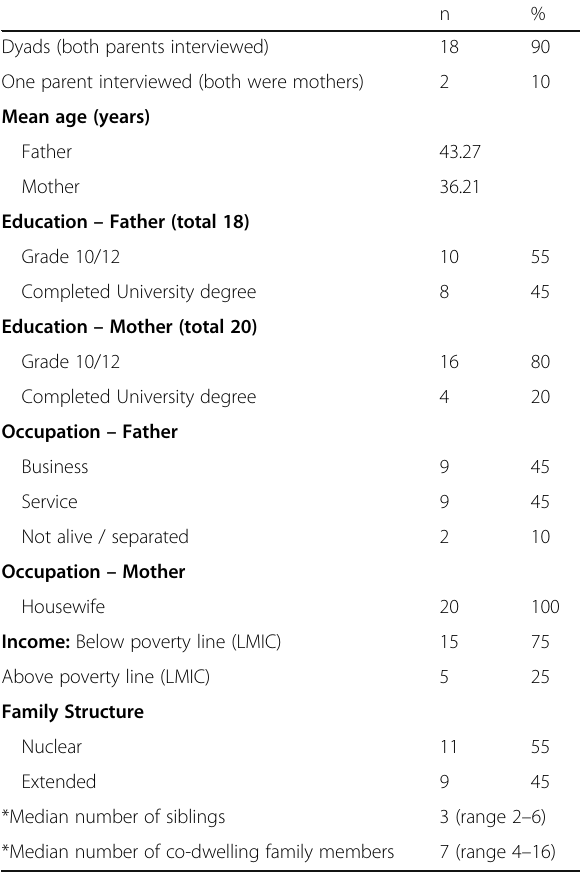
Table 1 Participants characteristics